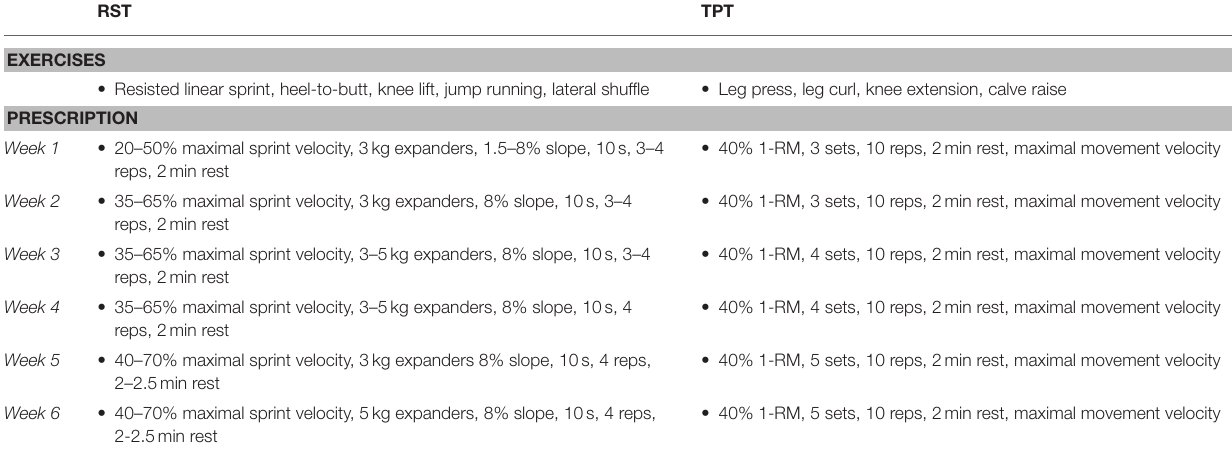
TABLE 2 | Progression during the 6 weeks of resisted sprint (RST) and traditional power training (TPT). RST